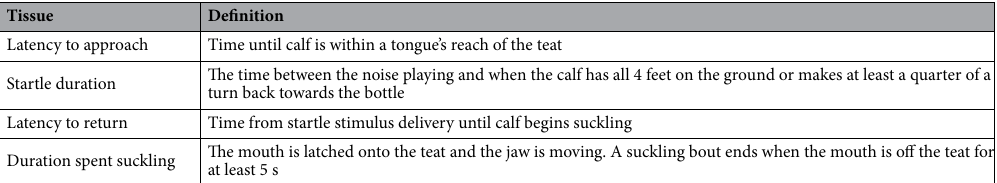
Table 1. Behavioural definitions used to evaluate calves’ responses in an arena test. As soon as the calf approached a milk bottle fitted with a rubber teat, a sudden noise was emitted to induce a startle response. The day before the startle test, the calf underwent a third and final period of habituation, in which the milk bottle was present, but no noise was emitted. Therefore, only latency to approach and duration spent suckling were scored during the habituation